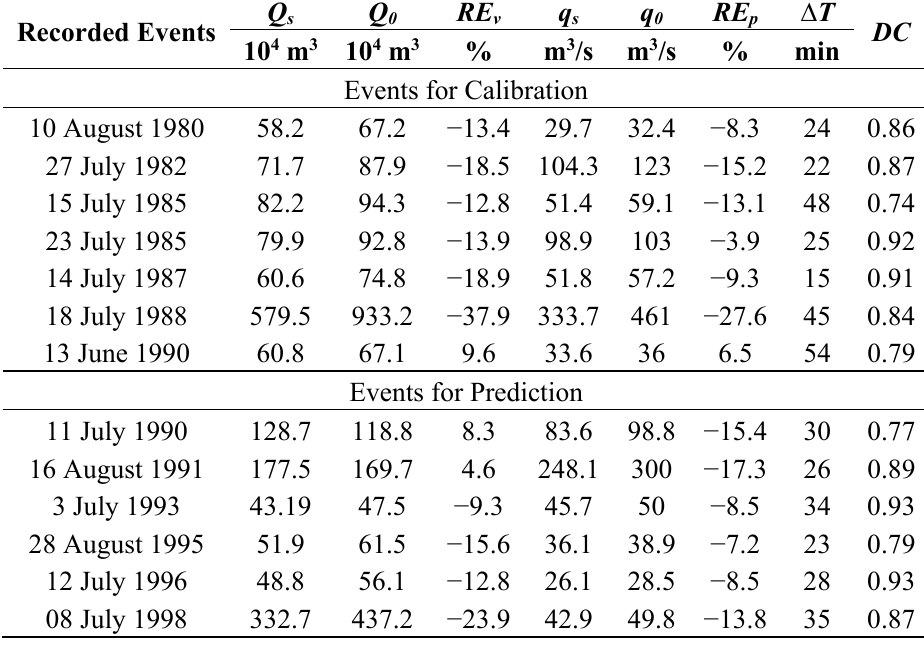
Table 7. The Modeling Results of Scheme